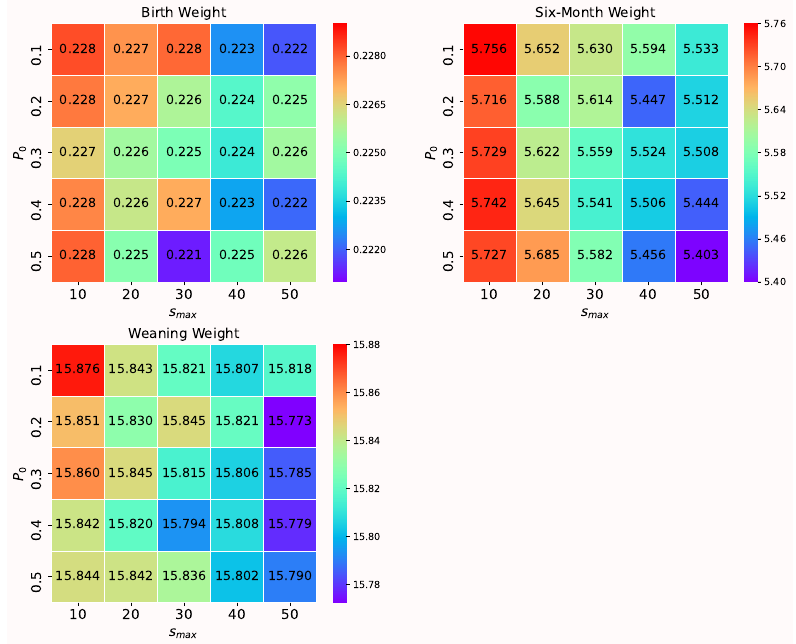
Figure 3. Mean squared error with different combinations s max and P 0 for analyzing the body weights on three